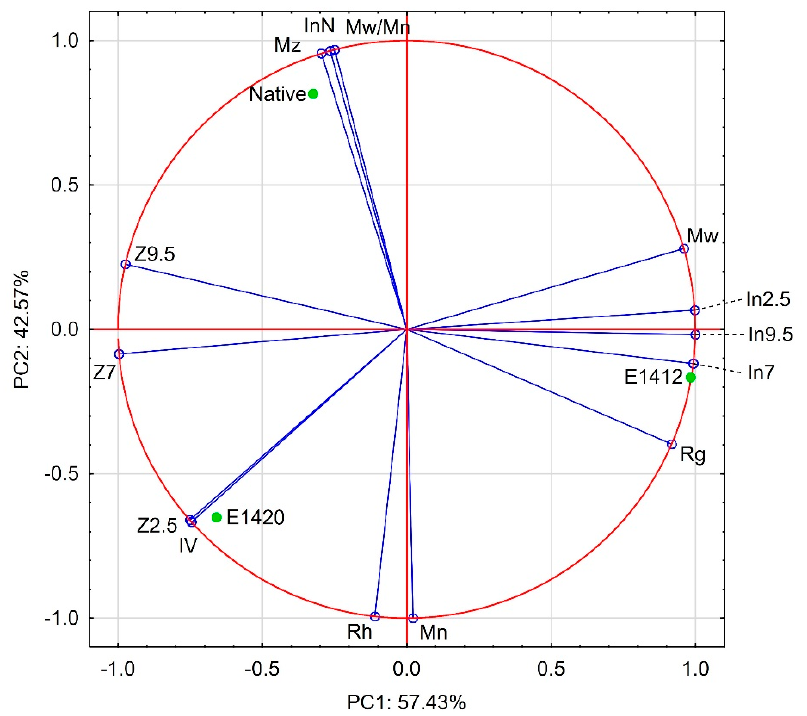
Figure 2. Principal Components Analysis of the data presented in Tables 6 and 7, as well as derived